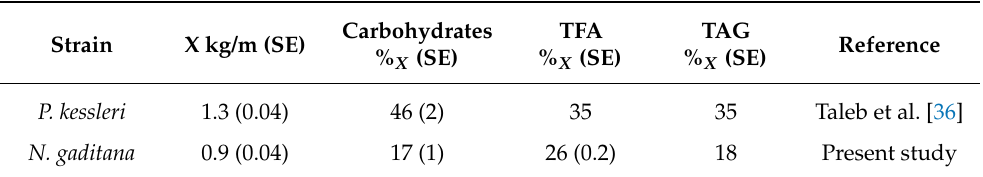
Table 1. Biochemical comparison of P. kessleri and N. gaditana at the end of batch culture under simulated DNc (11 days). Standard error for n =